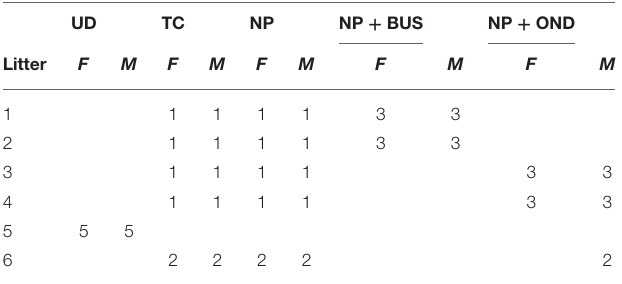
TABLE 1 | Distribution of sex and condition in experimental